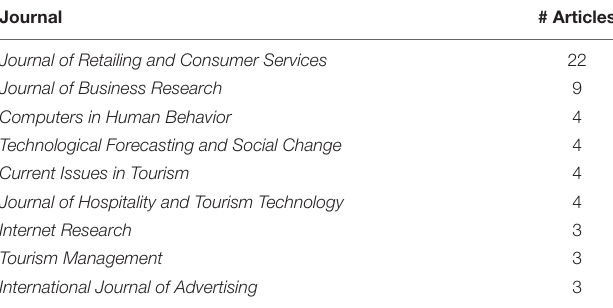
Frontiers in Psychology |